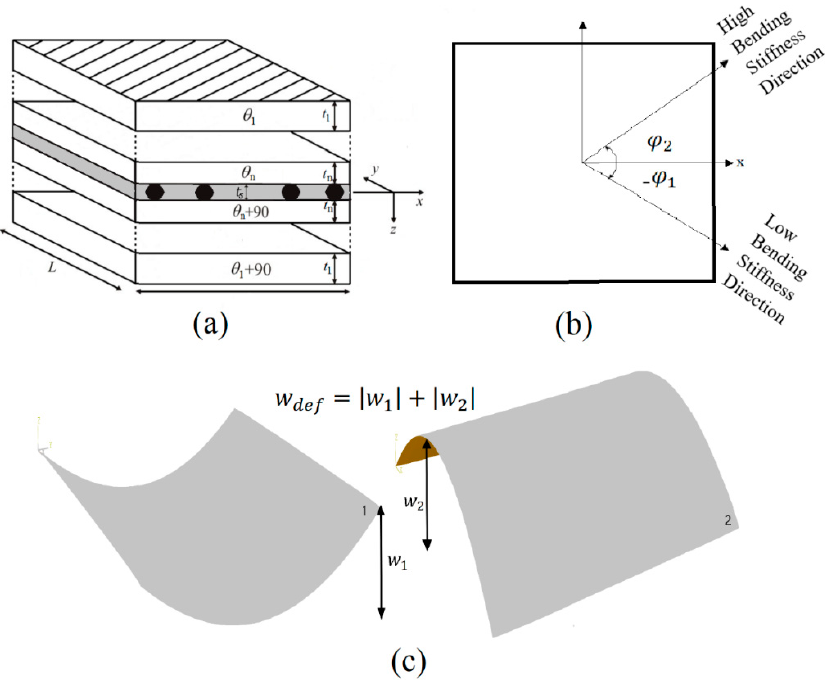
Figure 1. ( a ) Schematic of n-ply laminate (white) geometry with SMA / Epoxy layer (grey); ( b ) Directional stiffness positive in anticlockwise direction; ( c ) Deflection between two stable states for a cross-ply laminate.